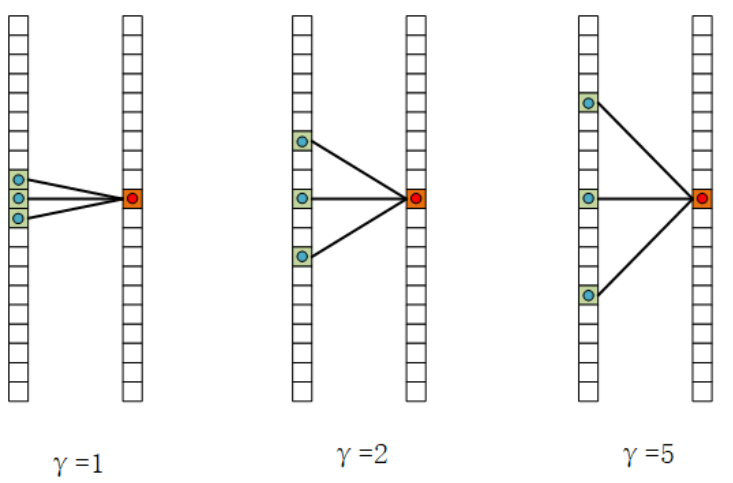
Figure 4. The illustration of temporal dilated convolution, the kernel is 3, γ means the dilation